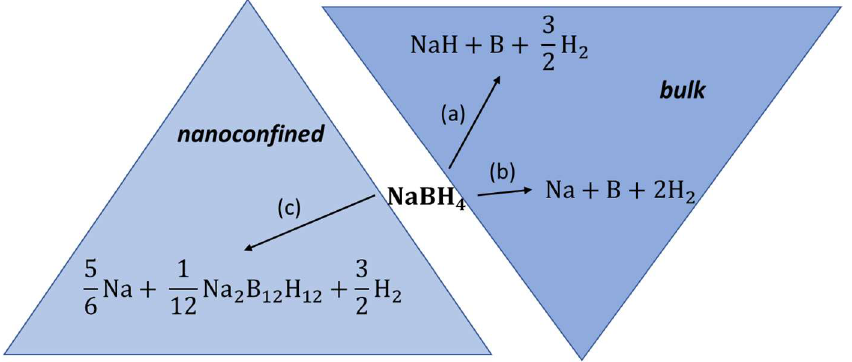
Figure 3. Possible decomposition pathways for bulk NaBH 4 (a,b) and for melt-impregnated, nano- confined NaBH 4 (c). fined NaBH 4